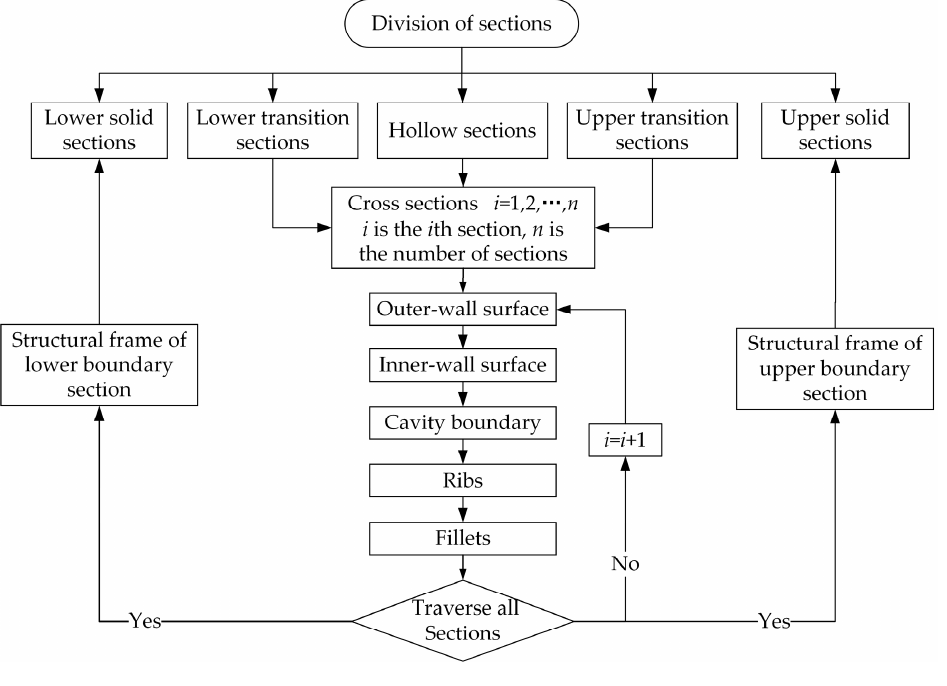
Figure 4. Establishment process of FEM.